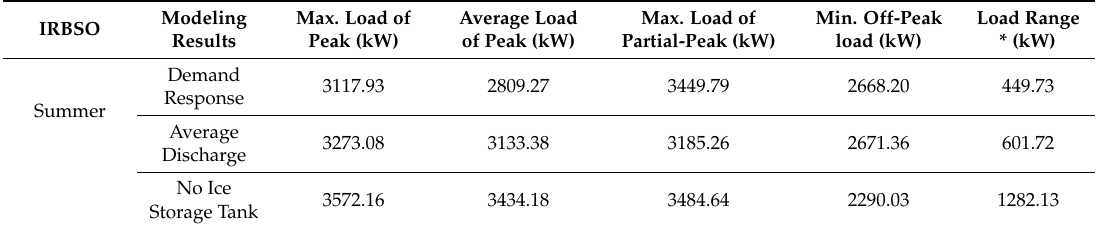
Table 9. Power load and dynamic electricity price for case